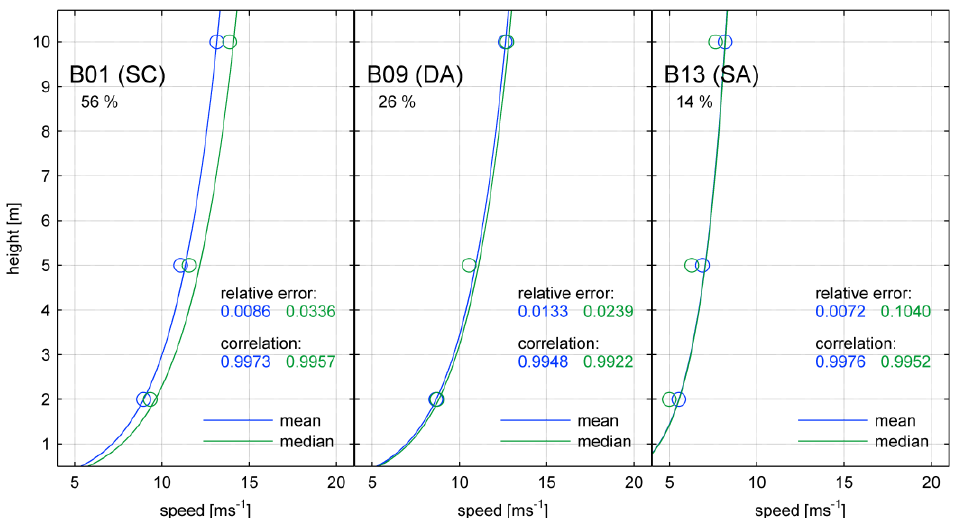
Figure 20. The measured (circle) and reconstructed (line) vertical wind speed profiles in the x -direction with a percentage of near-neutral 30-min intervals, relative errors, and correlations. The profiles reconstructed with the mean (median) values of 𝑢 ∗𝑝 (friction velocity estimated from wind profile) and 𝑧 0 are blue (green). The relative errors and correlations between the measurements and reconstructions are given in the corresponding colors.